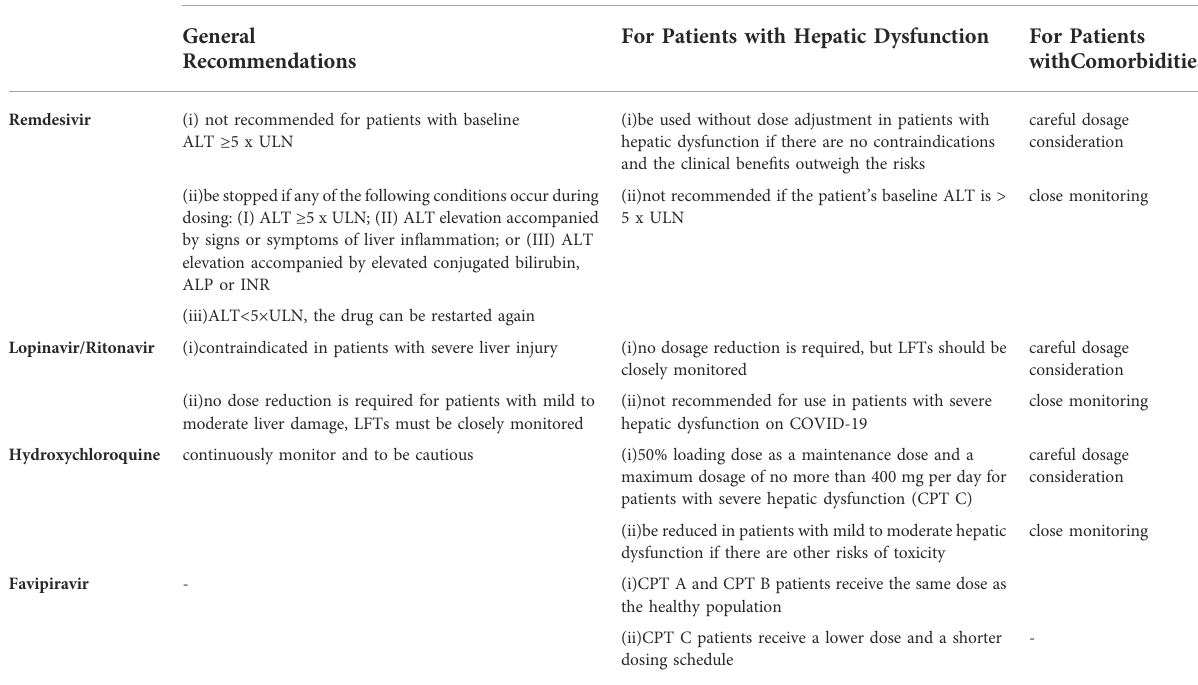
TABLE 3 Medication recommendations of antiviral